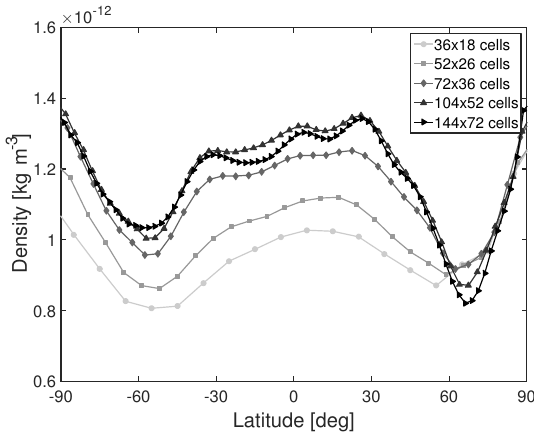
Figure 2. Grid sensitivity analysis at 0 ◦ latitude and 400km altitude (long × lat cells).